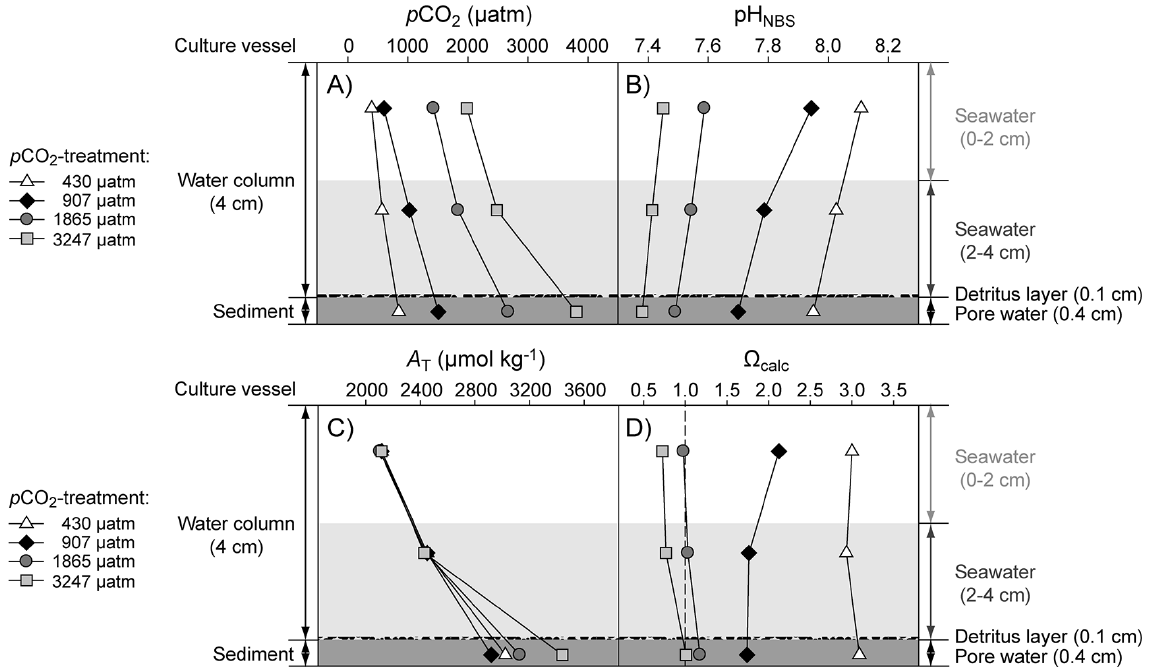
Fig. 2. Gradient of carbonate chemistry parameters of (A) partial pressure of CO 2 ( p CO 2 ) , (B) pH NBS , (C) total alkalinity ( A T ) and (D) saturation state of calcite ( (cid:127) calc ) in the seawater and sediment pore water for four p CO 2 treatments after 6 months of incubation